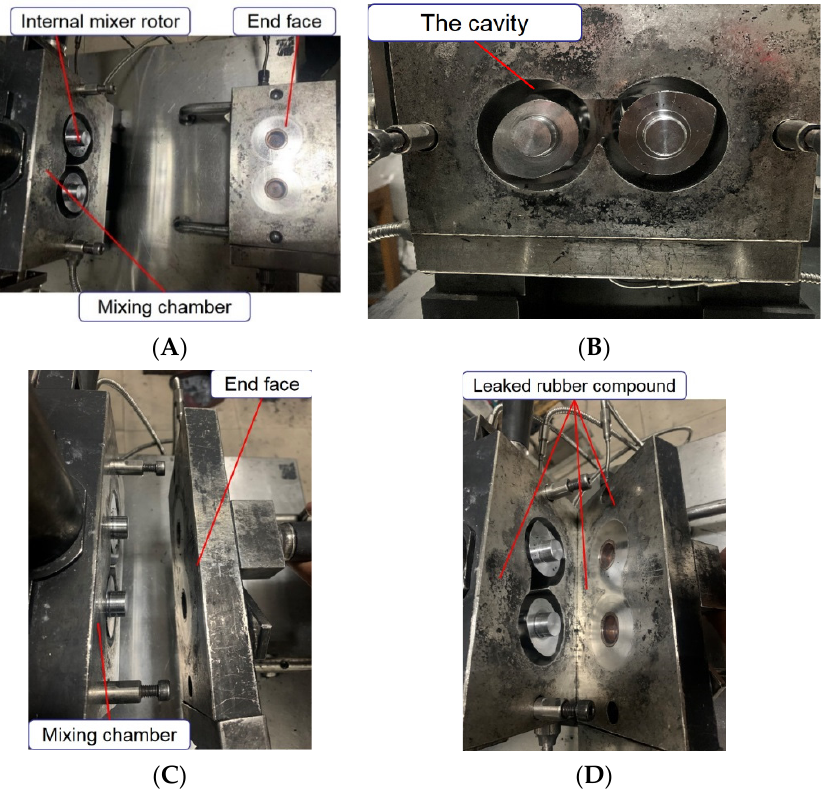
Figure 1. Rotor and end face of the mixer. (( A ) is a general view, ( B ) is a rotor, ( C ) is a top view, and ( D ) is a side view).